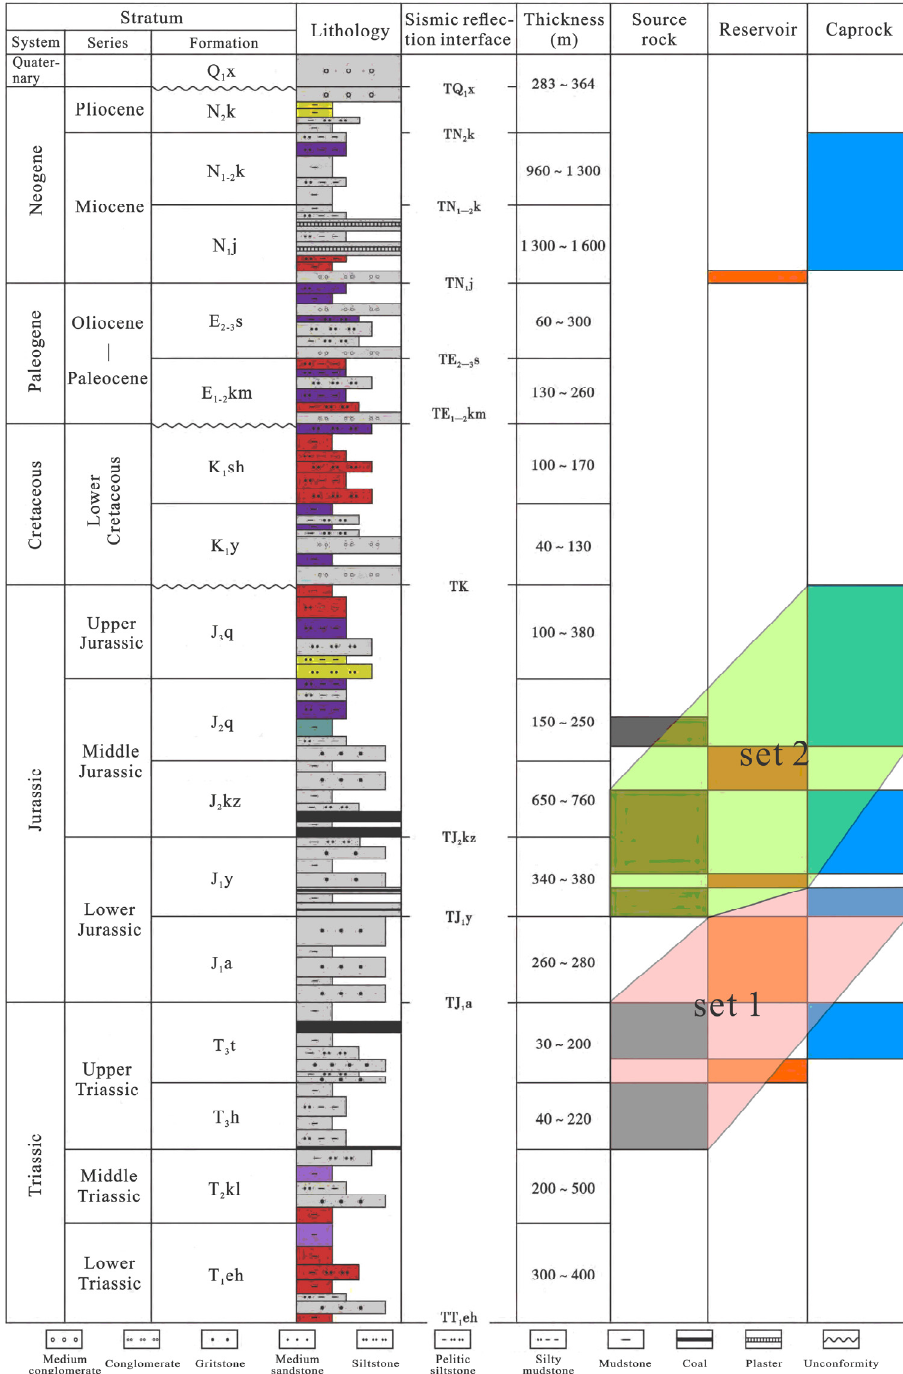
Figure 2. Mesozoic Cenozoic stratigraphic system in the northern tectonic belt of Kuqa Depression (after Wang et al., 2021